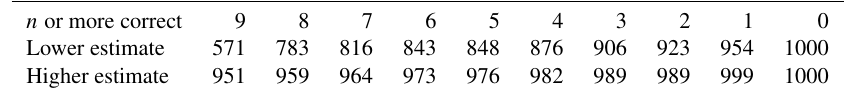
Table 2. Number of images with at least n correctly classified digits out of nine. The sample of 1000 images were manually viewed by all authors independently.